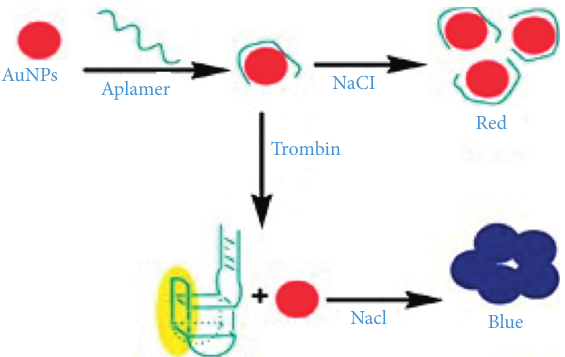
Figure 6: Gold nanoparticle colorimetric process for thrombin detection